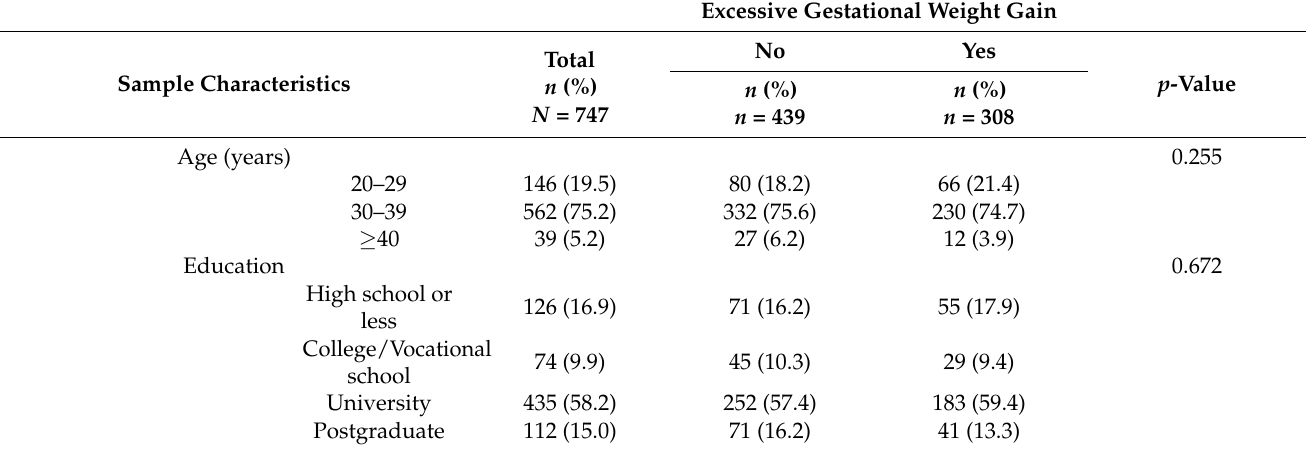
Table 1. Participant Characteristics by Excessive Gestational Weight Gain ( n =